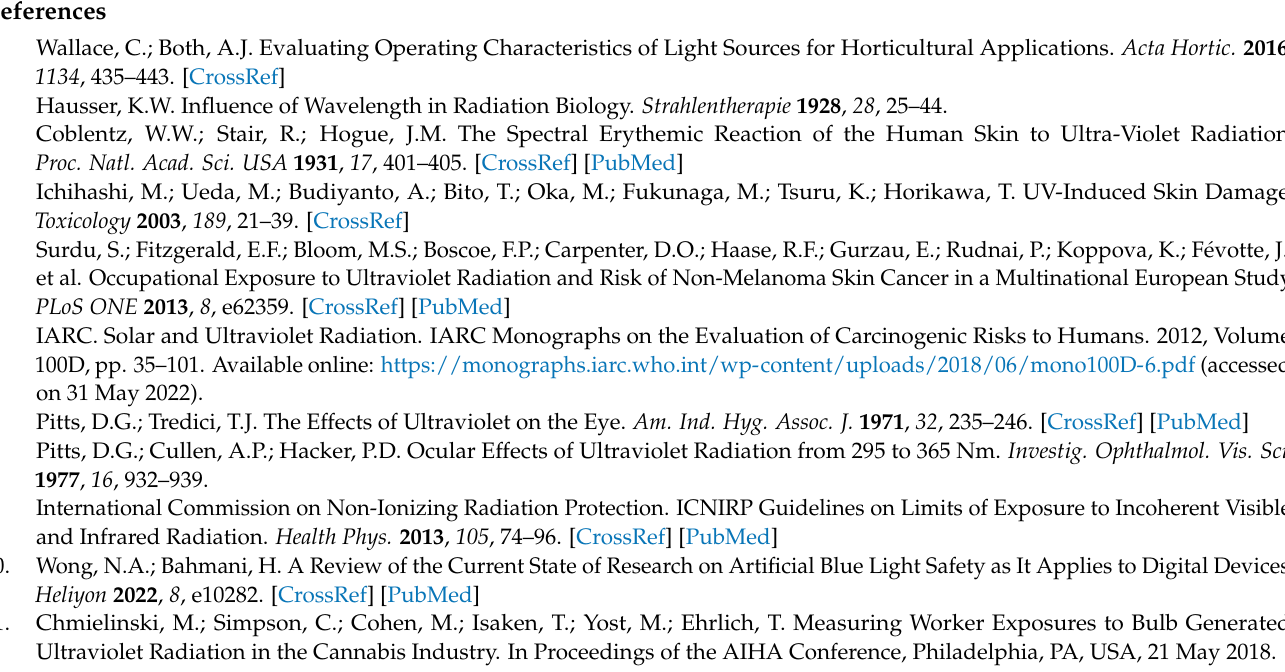
Table S1: Descriptions for each pin label. Table S2: The quality indices of the Ocean Insight